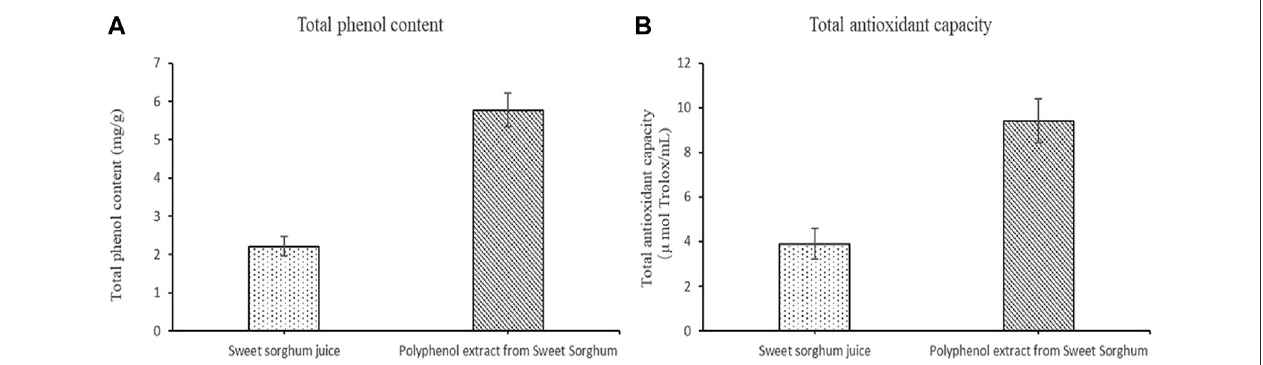
FIGURE 3 | Total phenol content and total antioxidant capacity of sweet sorghum juice before and after extraction (A) is the comparison of total phenol content beforeandafterextraction (B) isthecomparisonoftotalantioxidantcapacitybeforeandafterextraction.Thedataareexpressedasmean ± standarddeviation.One-way ANOVA ( p < 0.001) and Dunnett ’ s posttest were used for statistical